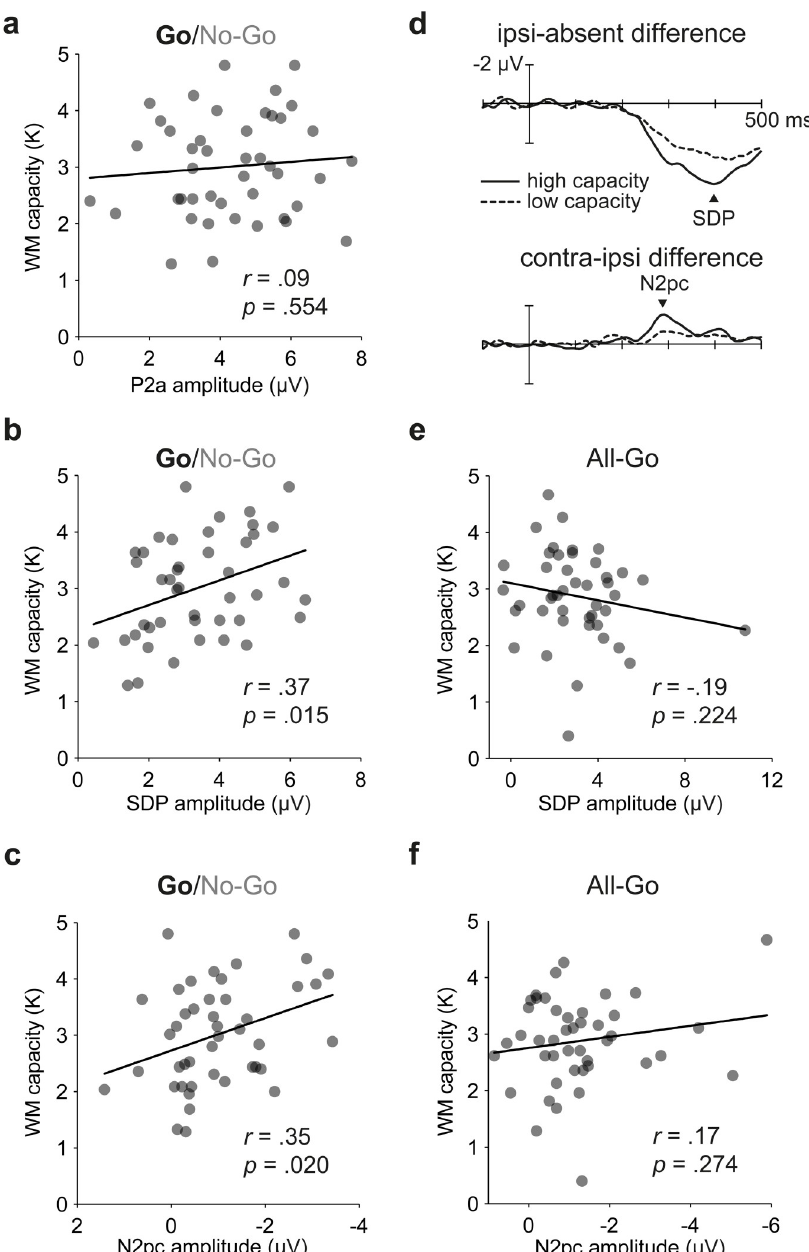
Fig 3. Bivariate relations between individuals’ WM capacities and amplitudes of isolated ERP indices of target- enhancement processes. The underlying data supporting this figure can be found at https://osf.io/4wdzq. ( a ) Display- relevance activity over the frontal scalp (P2a) in Experiment 1 did not predict WM capacity. ( b ) Singleton-detection activity over the posterior scalp (SDP) on Go trials of Experiment 1 predicted WM capacity. ( c ) Attentional-selection activity over the posterior scalp (N2pc) on Go trials of Experiment 1 also predicted WM capacity. ( d ) On Go trials (Experiment 1), SDP and N2pc were larger for high-capacity group than for low-capacity group. Difference waves are from occipital electrodes PO7/PO8. ( e ) Singleton-detection activity over the posterior scalp (SDP) did not predict WM capacity in Experiment 2. ( f ) Attentional-selection activity over the posterior scalp (N2pc) did not predict WM capacity in Experiment 2. ERP, event-related potential; N2pc, posterior contralateral N2; P2a, anterior P2; SDP, singleton detection positivity; WM, working memory.